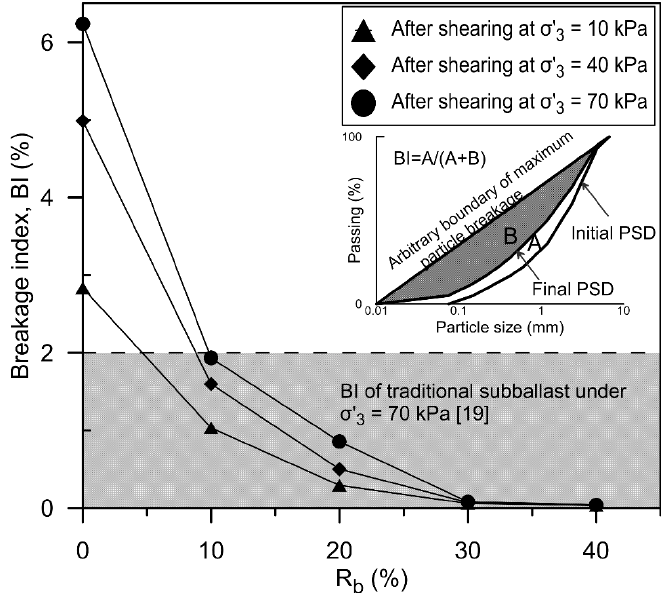
Figure 4. Breakage index of SFS+CW+RC mixtures.